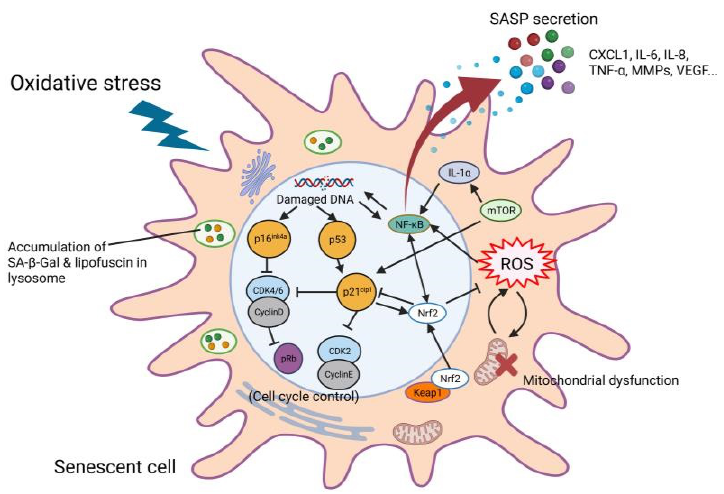
Figure 2. Schematic representation and molecular signaling network of a senescent cell. Stressors such as DNA damage, telomere erosion, and oxidative stress trigger cellular senescence by acting on the p16 INk4a /Rb and p53/p21 Cip1 pathway, leading to cell cycle ar- rest. p16 INK4a and p21 Cip1 are cyclin-dependent kinase (CDK) inhibitors. Inhibition of CDK arrests cell cycle progression from the G 1 to S phase, preventing DNA replication [61]. They were discovered as tumor suppressors in tumors from various tissues, and loss of p53, p16 INK4a , or p19 ARF leads to the inactivation of cellular senescence and malignant trans- formation [62]. p16 INK4a and p21 Cip1 trigger general aging, cellular senescence, and age-re- lated disorders [63]. p16 INK4a is encoded by CDK inhibitor 2A in the INK4a/ARF locus on chromosome 9p21.3, which also encodes p19 ARF [64]. p16 INK4a binds to CDK4/6 and inhibits CDK4/6-cyclin D complex formation, decelerating the cell cycle by inhibiting S phase by preventing the phosphorylation of hypophosphorylated retinoblastoma protein (Rb) (p16 INK4a /pRb pathway). Via these mechanisms, p16 INK4a suppresses tumor progression, and the loss of p16 INK4a leads to malignancy and/or a higher grade of malignancy [65]. In addition, p16 INK4a is associated with aging, apoptosis, cell invasion, and angiogenesis. p16 INK4a and p19 ARF increase in the aged brain, heart, and lung tissues, implicating p16 INK4a and p19 ARF in physiological aging and the deterioration of organ function with age [66,67]. Moreover, selective elimination of p16 INK4a positive cells extends the lifespan, suppresses tumorigenesis, and prevents age-related disorders including cataract [68]. Therefore, cel- lular senescence associated with the p16 INK4a /Rb pathway is a critical driver of age-related diseases, and therapeutic removal of senescent cells (senolysis) could prevent age-related diseases. p21 Cip1 is a cyclin-dependent kinase inhibitor encoded by CDK inhibitor 1A on chro- mosome 6p21.2 [69]. p21 Cip1 acts downstream of p53 (encoded by TP53). ROS activate the p53/p21 Cip1 pathway by triggering the DNA damage response. Upon DNA damage or en- dogenous/exogenous stressors, p53 is activated and transcriptionally upregulates target genes including p21 Cip1 (p53/p21 Cip1 pathway) [70]. p21 Cip1 binds to CDK2 and CDK4/6, causing cell cycle arrest at the G1 and S phases [71]. p21 Cip1 contributes to DNA repair, the modulation of apoptosis, and transcriptional regulation as well as cell cycle arrest [72]. Senescent cells have increased senescence-associated β -galactosidase (SA β -Gal) ac- tivity. The evaluation of SA β -Gal activity is used to identify senescent cells. Cells with replicative senescence or SIPS show β -galactosidase activity at pH 6.0, whereas normal cells have β -galactosidase activity at pH 4.5 [73].